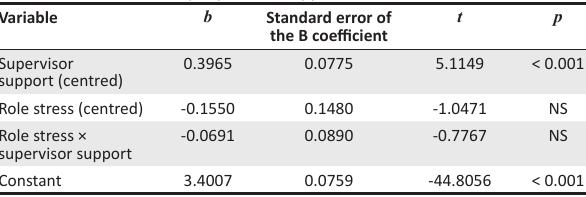
FIGURE 3: Diagram of the job satisfaction moderation model with regression coefficients and interaction TABLE 6: Multiple regression analysis’ summary for role stressors and job satisfaction moderated by supervisor support.